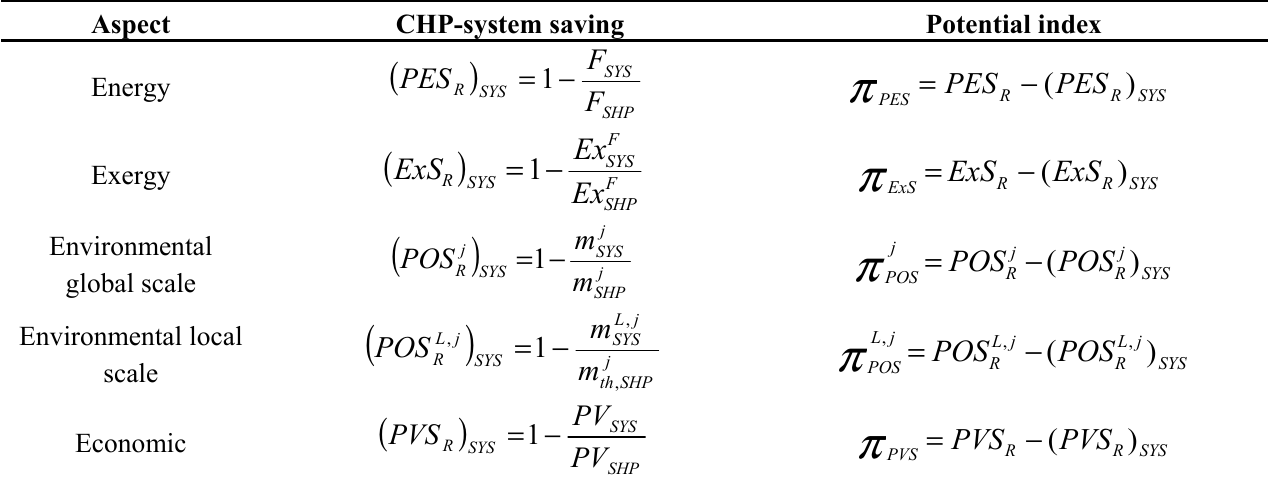
Table 3. Summary of the main equations used to analyse the CHP-system. Aspect CHP-system saving Potential